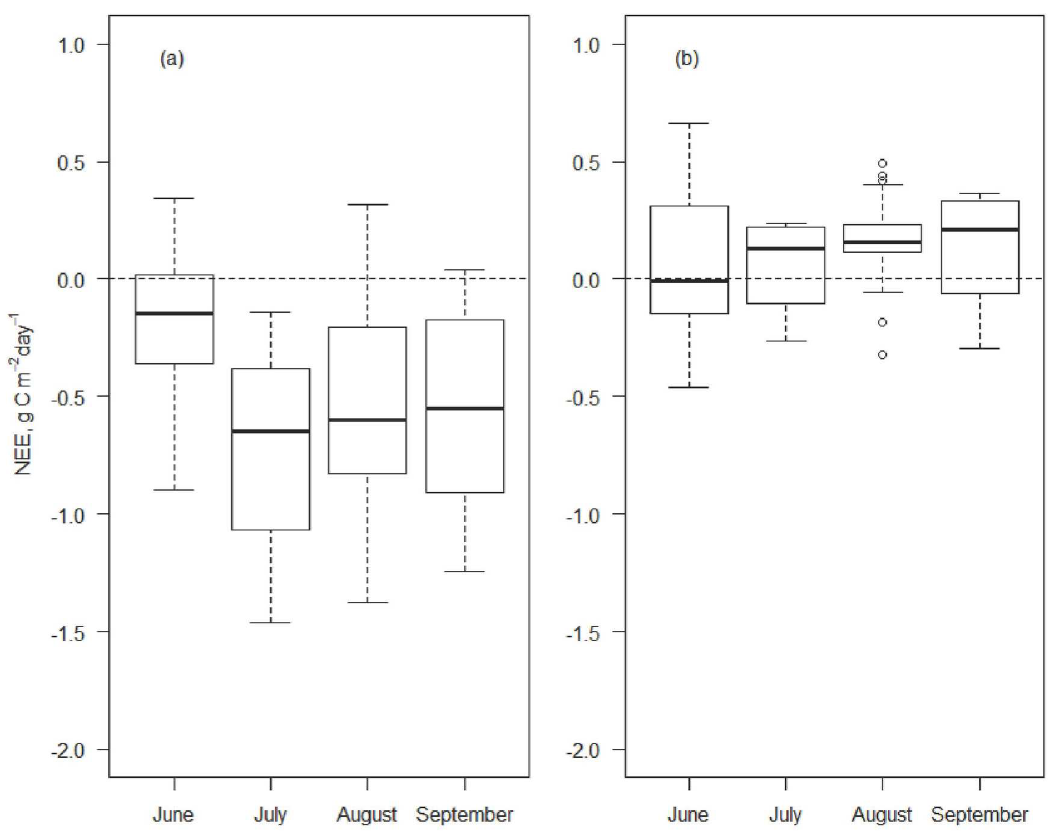
Fig 7. Box plots of cumulated daily values of net ecosystemexchange (NEE). Fluxes are measuredwith the long- term transparentchambersin 2013(g C m -2 day -1 ) in (a) Festuca and (b) Sempervivum plots.